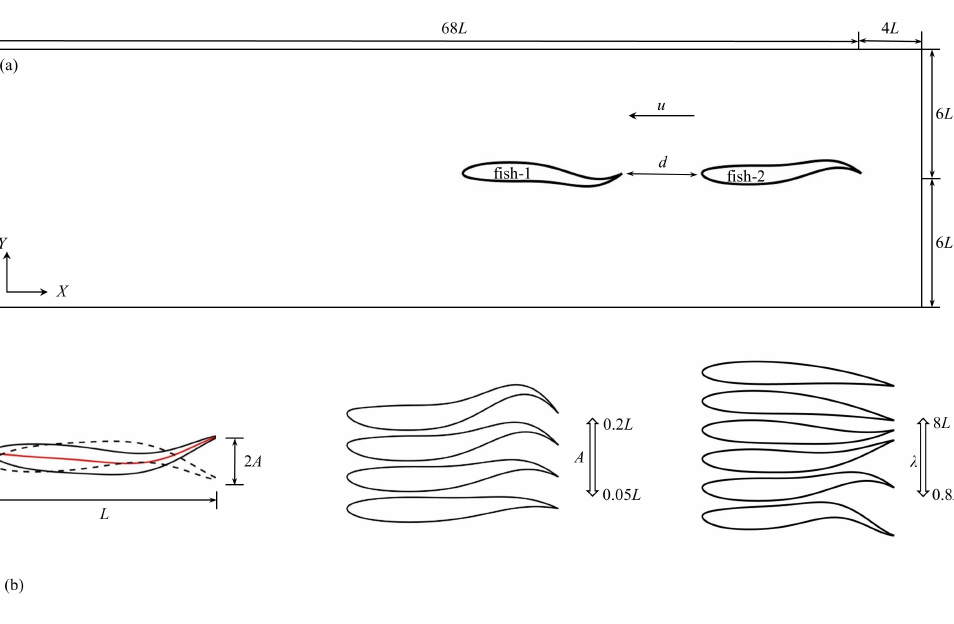
Figure 1. ( a ) Sketch of computational domain. ( b ) Fish